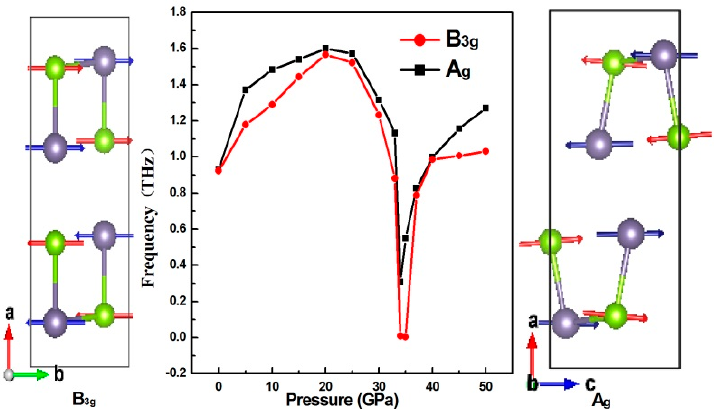
Figure 8. Hydrostatic pressure dependence of the calculated Raman-active B 3g and A g shear phonon modes. The corresponding phonon eigenvectors are shown together with the VESTA code.